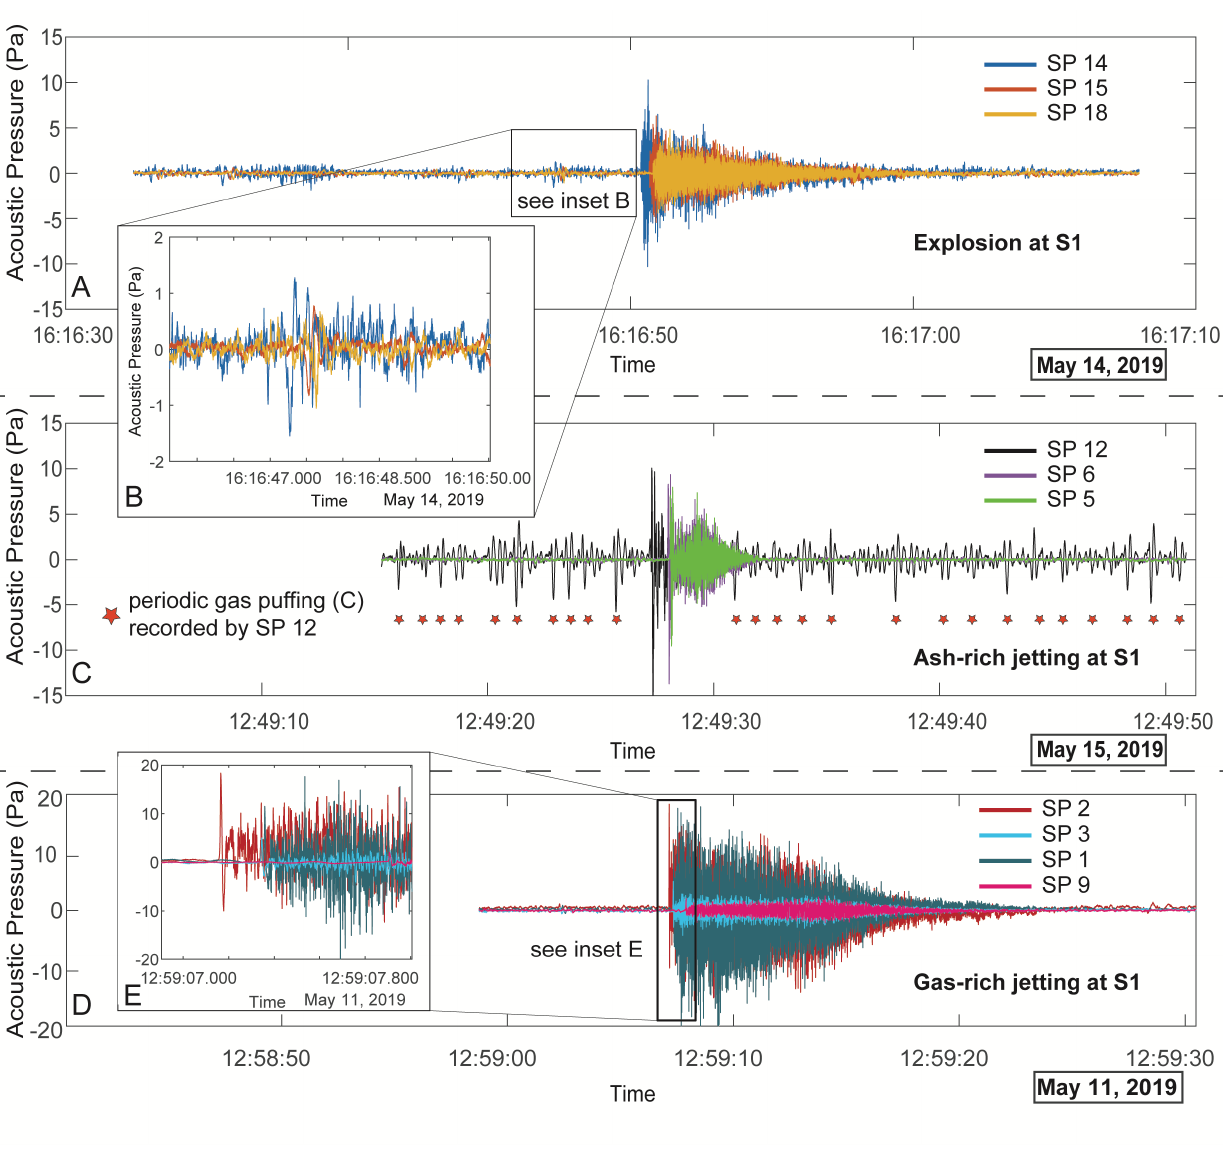
Figure 4: Three explosive events recorded at Stromboli volcano. [A] shows the acoustic signal of three SPs (#14, #15, #18) on 14 May 2019 at 16:16 UTC. Refer to Figure 3 for additional data of SP14. Smaller acoustic events before the main explosion of S1 can be seen in inset [B]. [C] On 15 May 2019 an ash-rich jet was emitted by S1 that was recorded by three SPs (#12, #6,